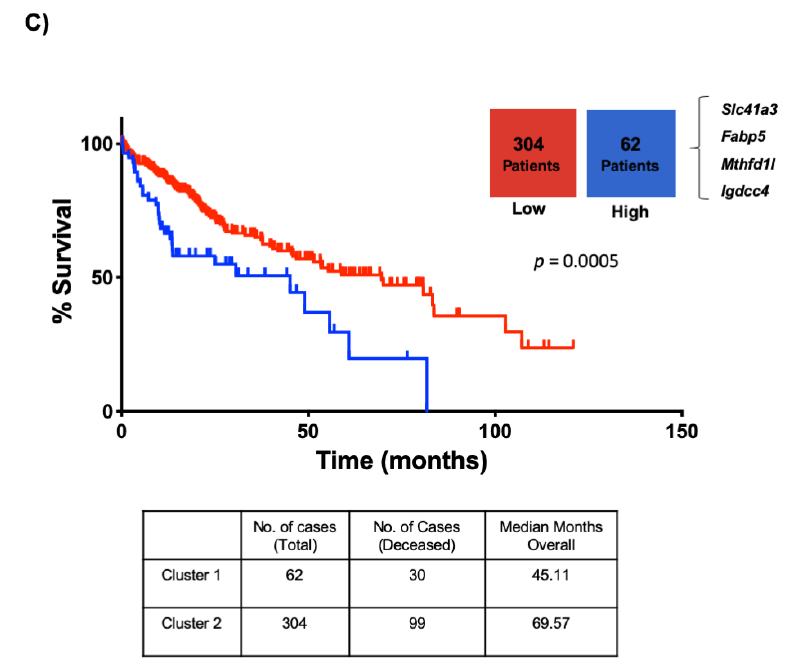
Figure 7. Lipid-associated four-gene signature defines a subtype of human liver cancer with a poor prognosis. ( A ) Plots chart showing higher expression of Slc41a3, Fabp5, Igdcc4 and Mthfd1l in human HCC ( n = 371) compared to no-tumor liver tissue (NL, n = 50) according to the TCGA database (https://www.cbioportal.org/, accessed on 10 November 2020). TPM, transcripts per million. * p < 0.01 vs. normal liver (NL). ( B ) Kaplan–Meier curves of overall survival in HCC patients. Patients with HCC were separated into two groups, high (red) and low (black) expression of Slc41a3 ( p = 0.0138), Fabp5 ( p = 0.0005), Igdcc4 ( p = 0.0010), and Mthfd1l ( p = 0.0328). ( C ) HCC data set from the TCGA was divided into unaltered and altered groups regarding the four-gene signature, and the overall survival in HCC patients was addressed and plotted in a Kaplan–Meier curve (altered red group) and low (unaltered black